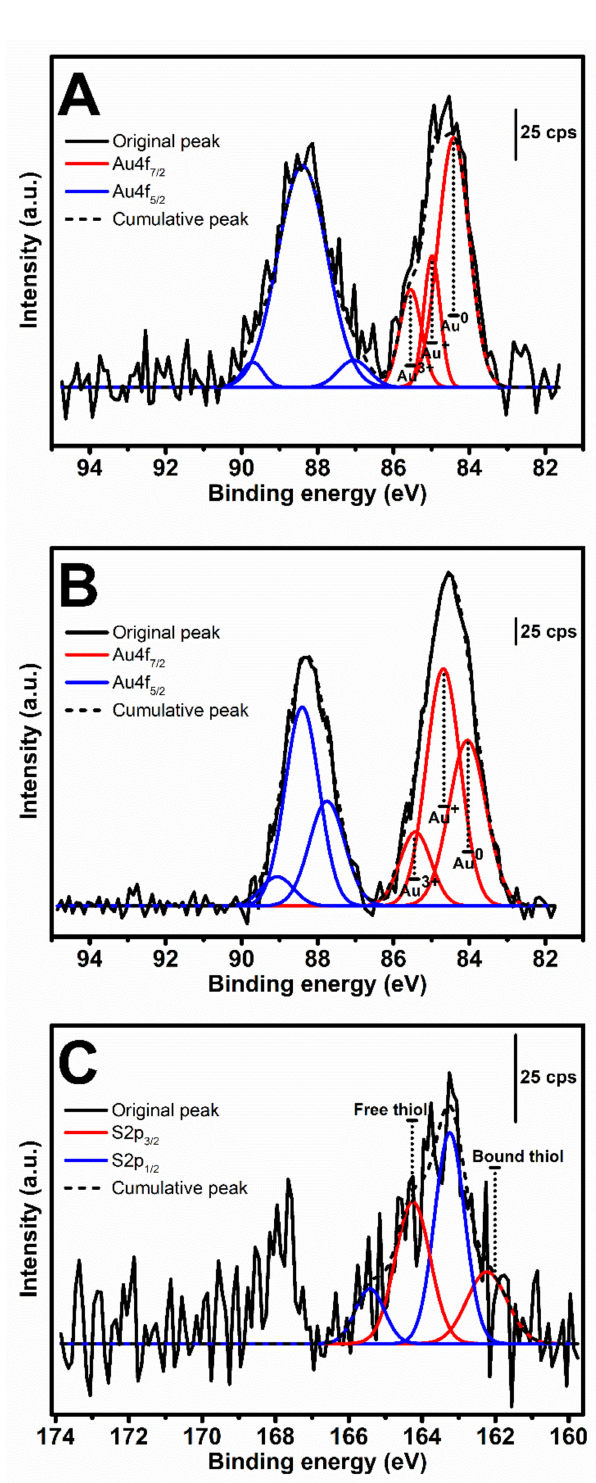
Figure 4. XPS spectra in Au4f region of ( A ) Au-SF and ( B ) Au-tSF, and in ( C ) S2p region of